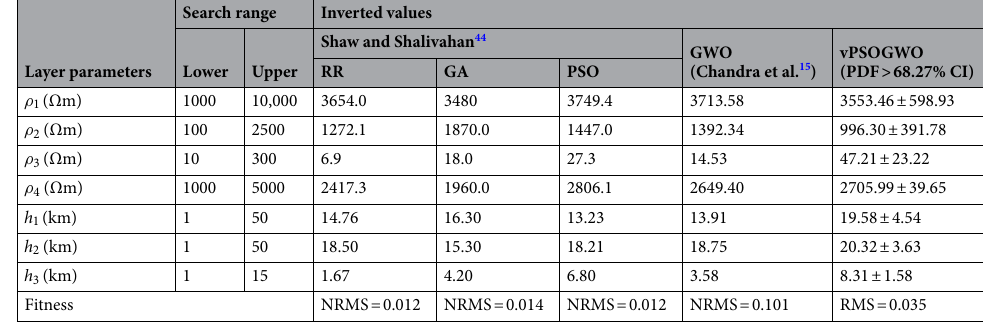
Table 9. Mean model with the level of uncertainty in the posterior utilizing individual inversion of MT data from the findings of the vPSOGWO, compared with results inverted from Shaw and Shalivahan 44 and Chandra et al. 15 over Sundar Pahari, Dhanbad, India.